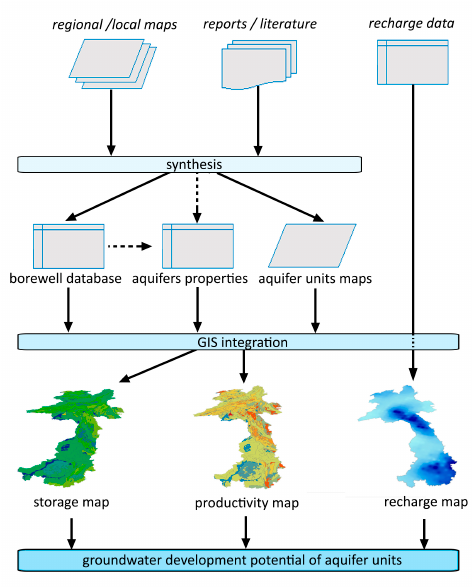
Figure 2. General workflow of the study.